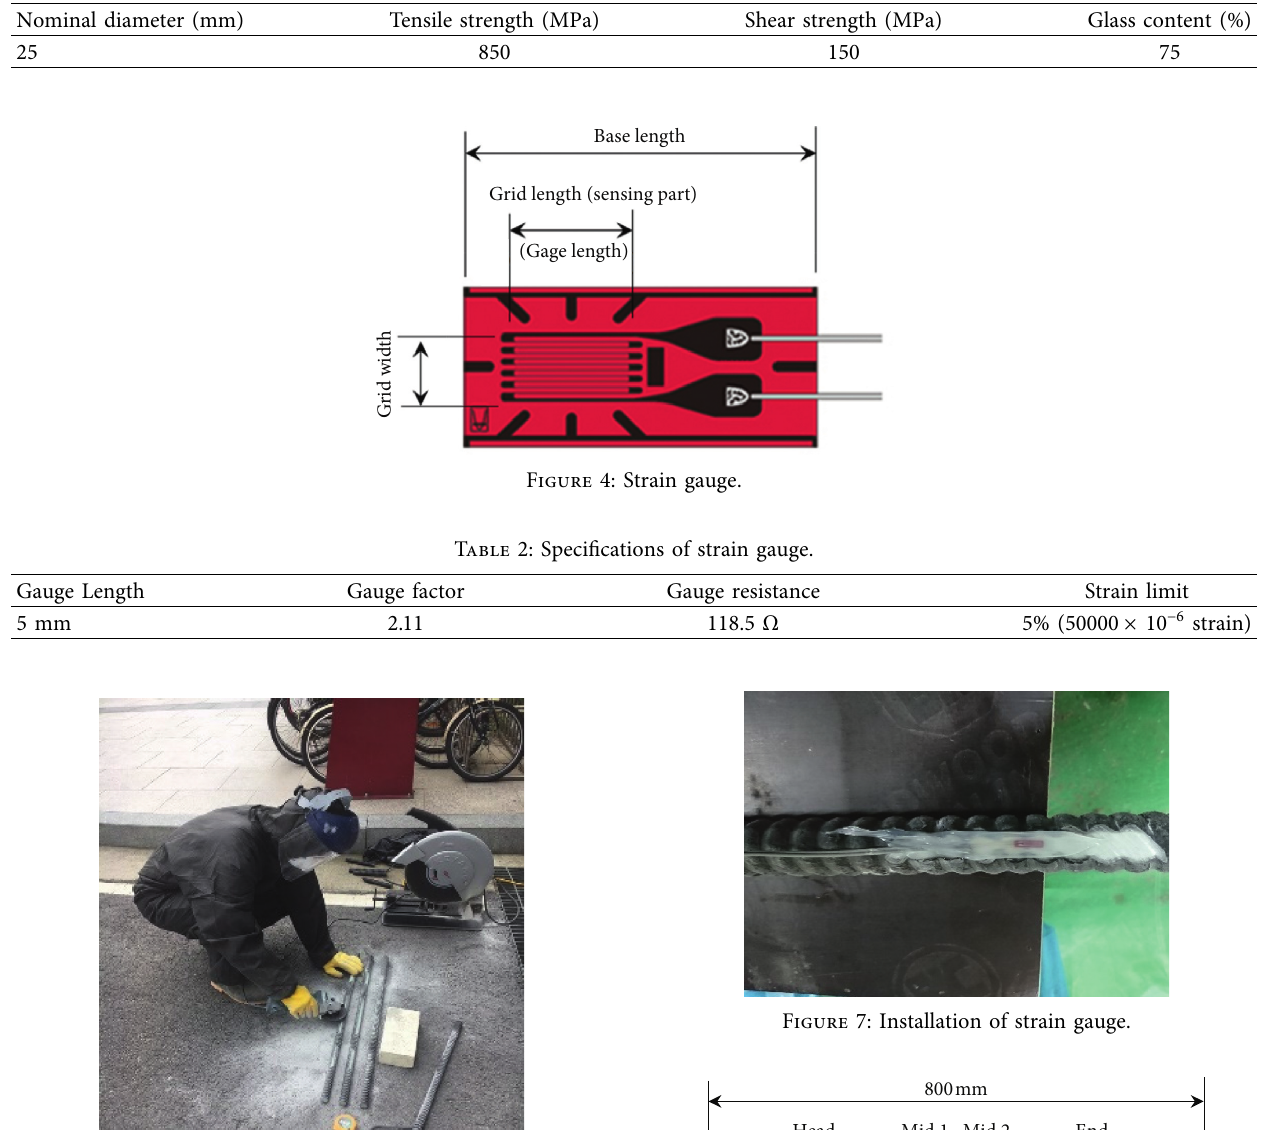
Table 1: Specifications of GFRP rock bolt.